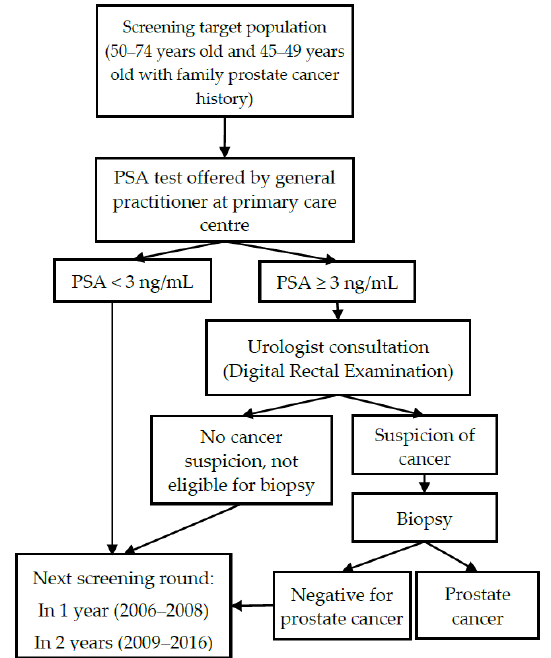
Figure 1. Organizational structure of Early Prostate Cancer Detection Programme in Lithuania between 2006 and 2016; PSA, prostate specific antigen.